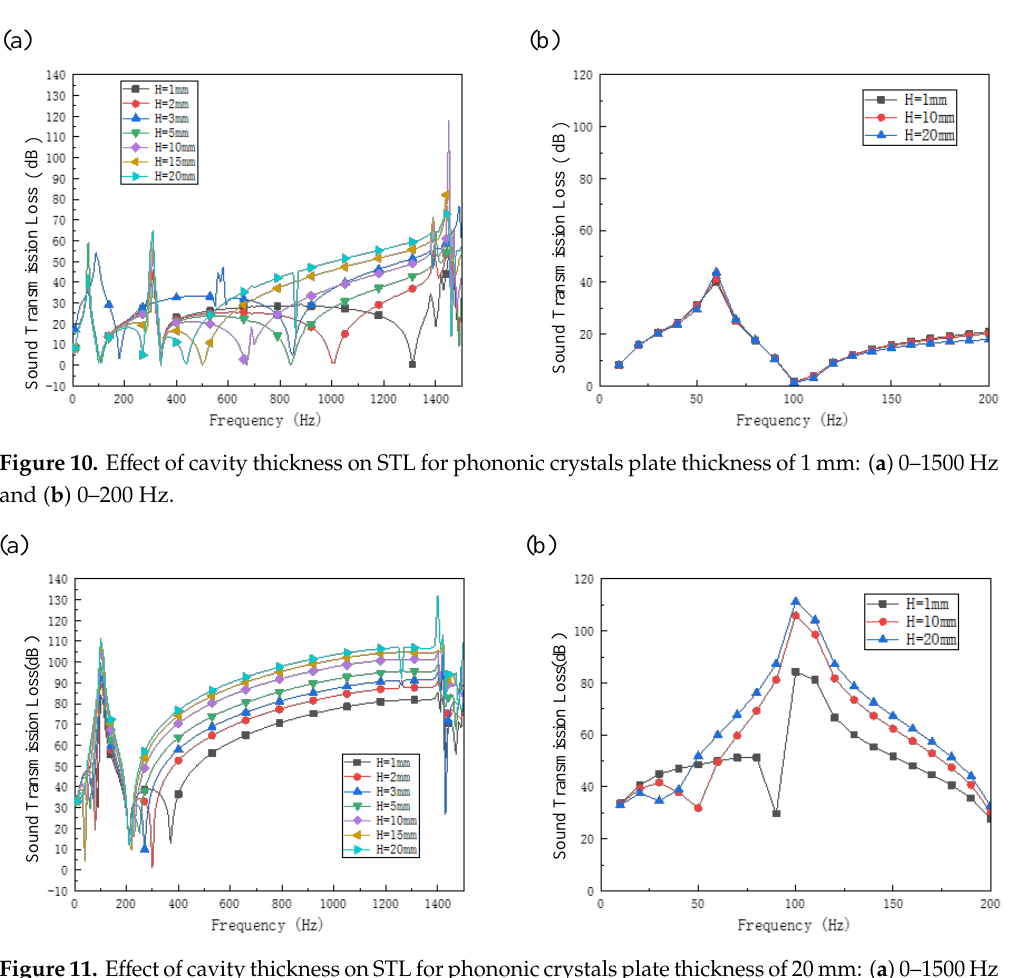
Figure 11. Effect of cavity thickness on STL for phononic crystals plate thickness of 20 mm: ( a ) 0 – 1500 Hz and ( b ) 0 – 200 Hz.